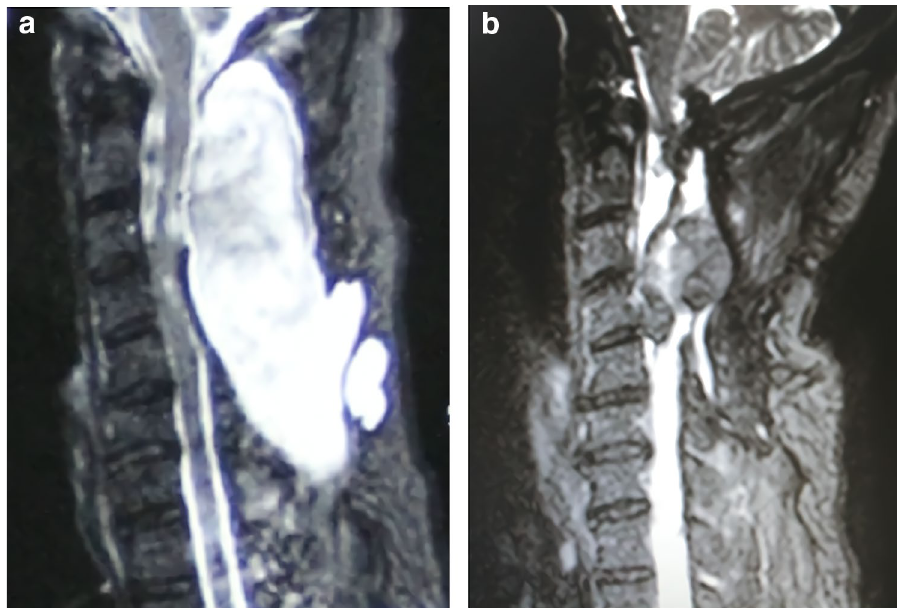
Figure 1. The first case. ( a ) Pre-operative area of the pseudomeningocele on sagittal MRI section. ( b ) Post- operative area of the pseudomeningocele on sagittal MRI section.